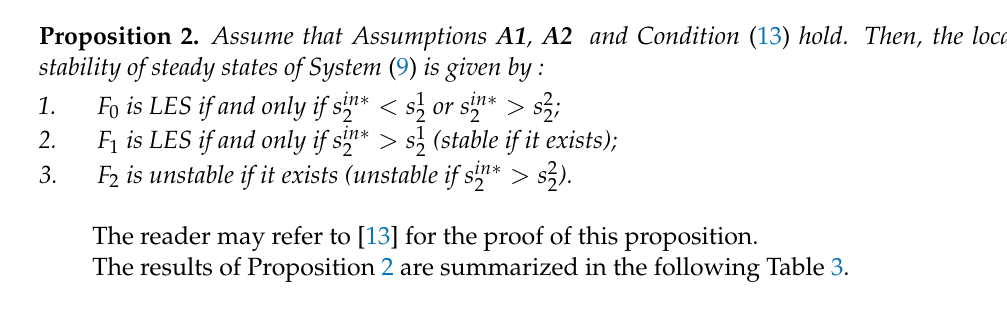
Table 3. Summary of the results of Proposition